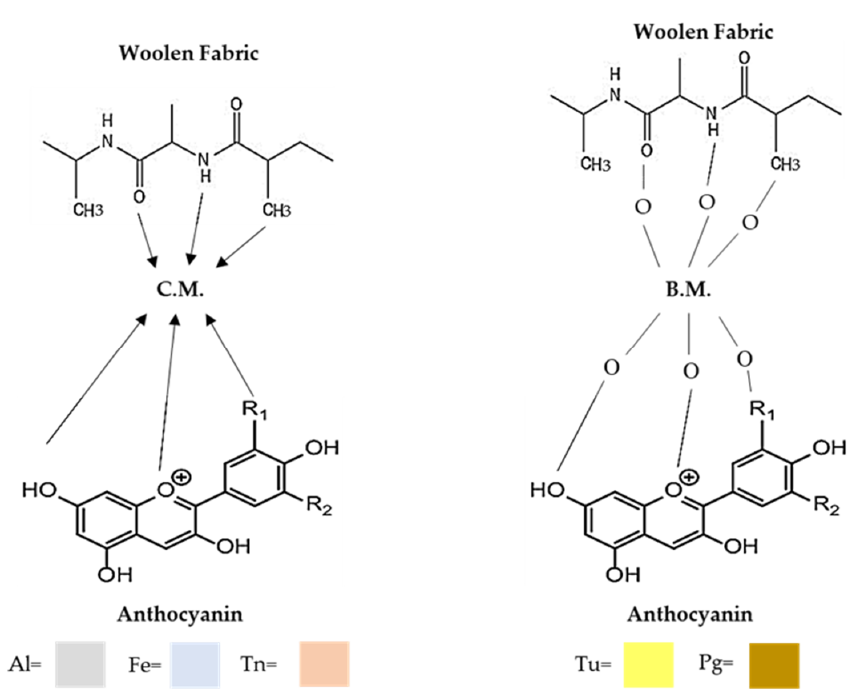
Figure 9. Proposed interaction of colorant functional sites with woolen fabric functional sites in the presence of chemicals and biomordants. C.M, chemical mordant; B.M, biomordant; Al +3 , aluminum; Fe +2 , iron; Tn, tannic acid; Tu, turmeric; Pg, pomegranate.